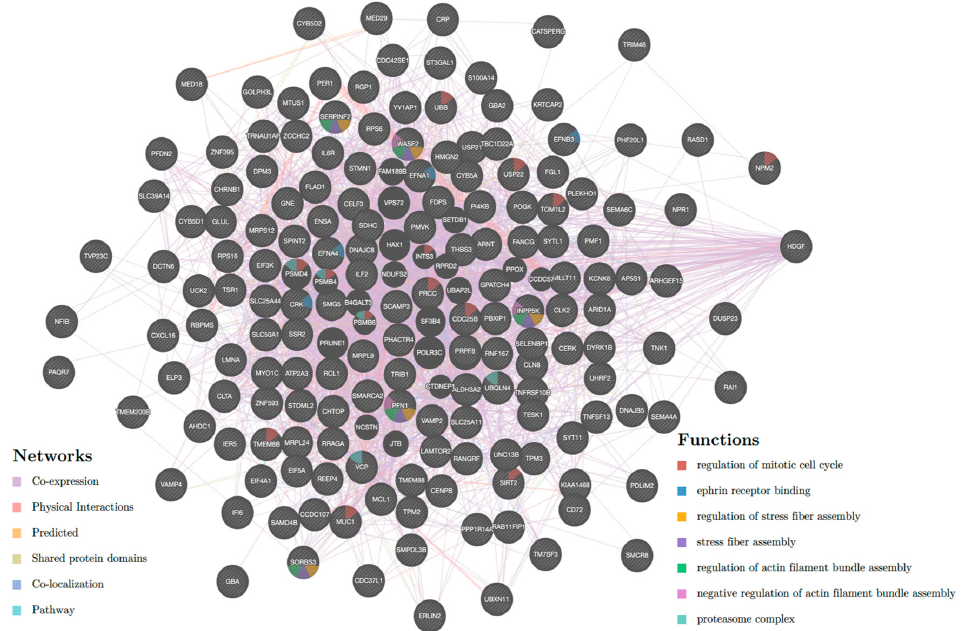
Figure 3. Pathway enrichment analysis performed using software Enrichr on 169 genes regulated by enhancers.